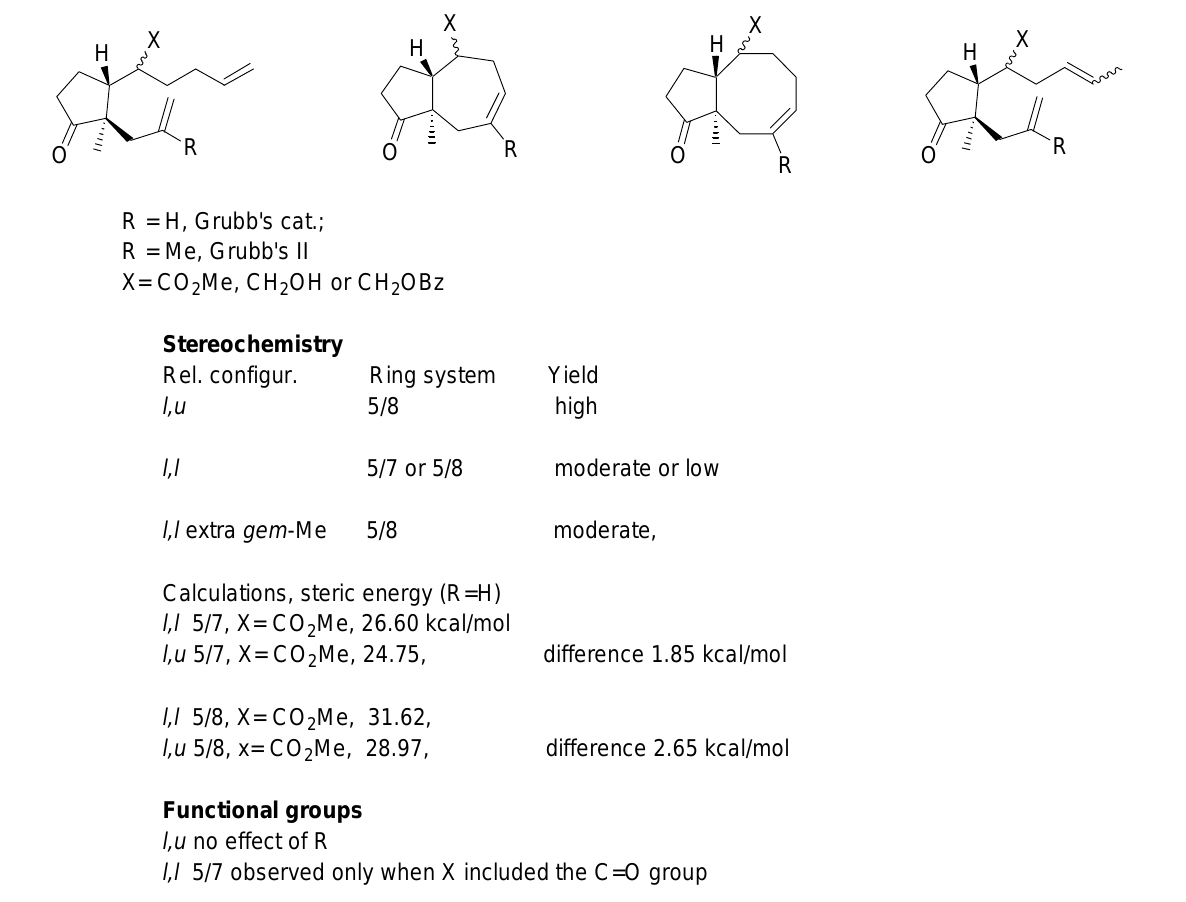
Scheme 18. Summary of annulation